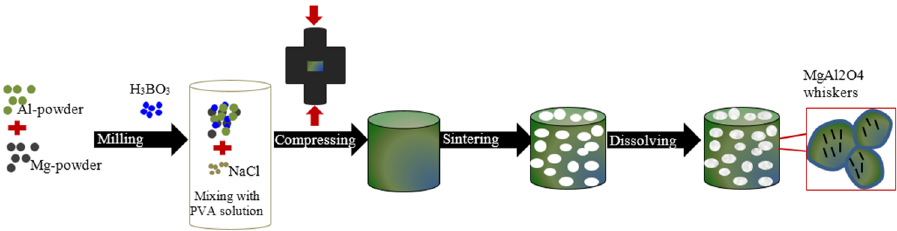
Figure 13. Schematic illustration of procedures to fabricate Al composite foams reinforced byMgAl 2 O 4 spinel whiskers [153].